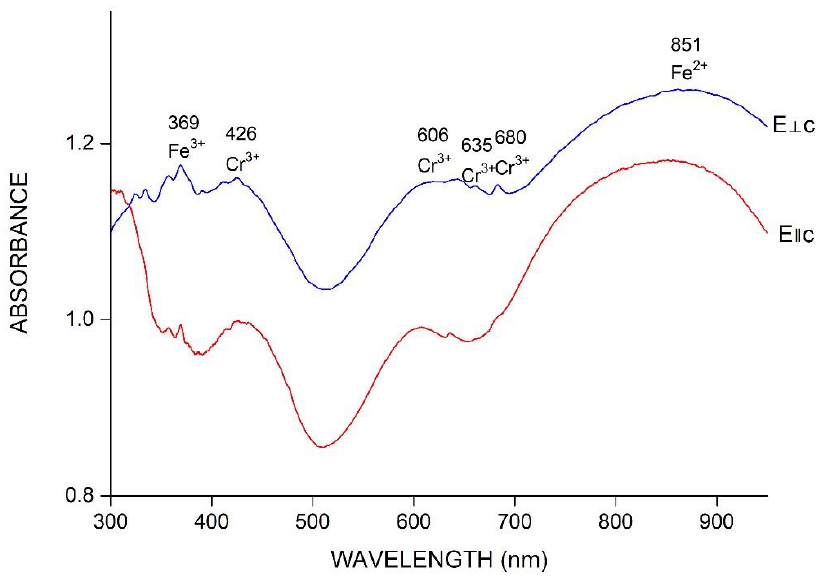
Figure 11. Representative UV-Vis-NIR spectra of samples 94-6 Indian emeralds.